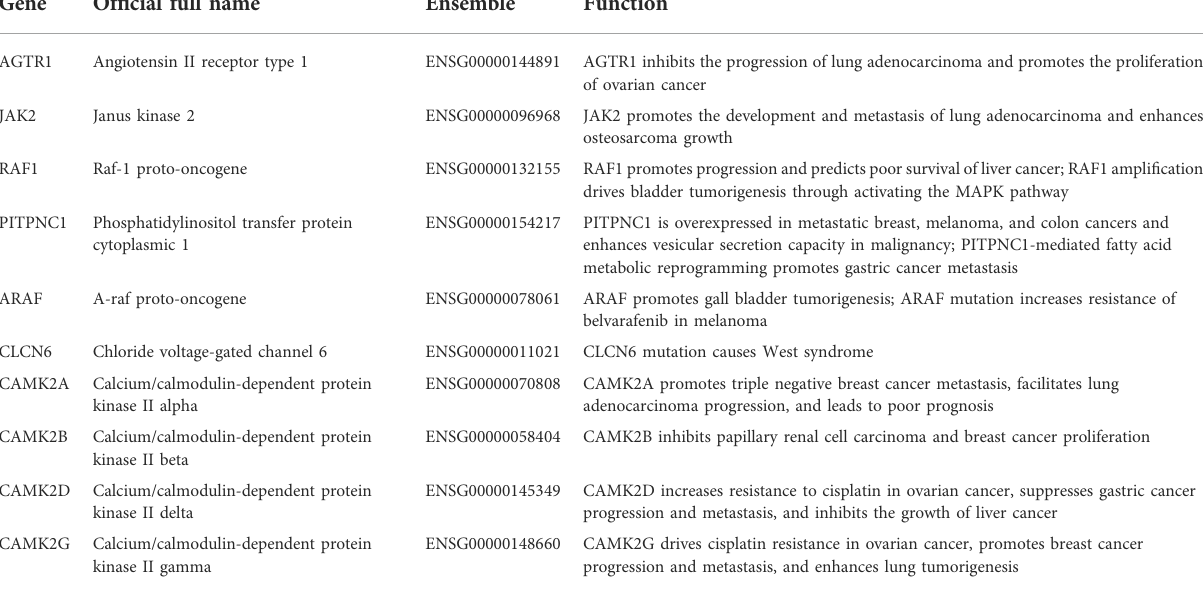
TABLE 1 AGTRAP-related genes.